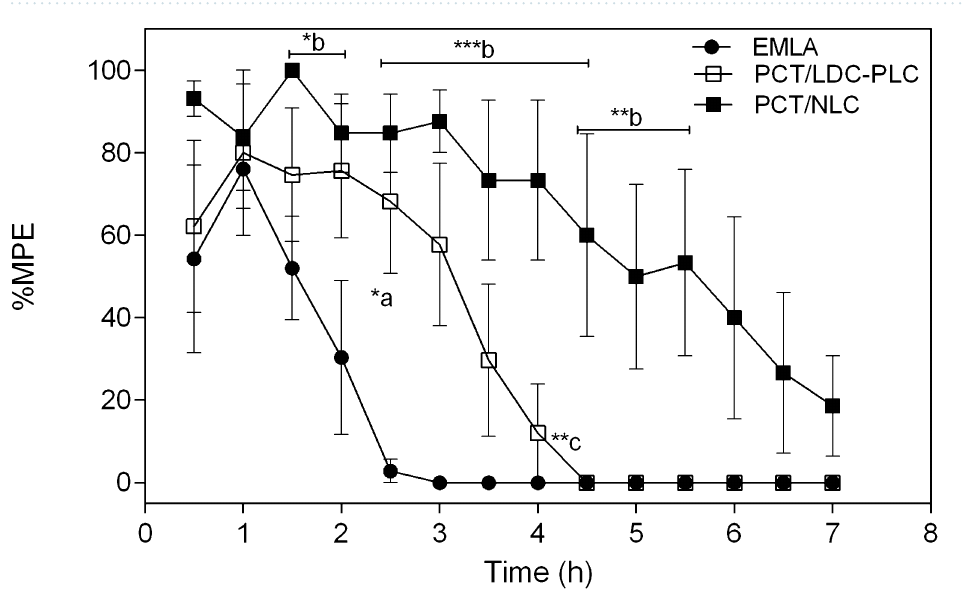
Figure 5. Anesthetic effect (tail-flick) test in mice treated with PCT/LDC-PLC, PCT/NLC and EMLA cream, containing 5% LDC-PLC. Results were expressed as maximum possible effect (%MPE) vs time (h). Data are mean ± SEM (n = 6). Statistical analyses were carried out by one-way ANOVA plus Tukey post hoc: a, PCT/LDC- PLC × EMLA cream; b, PCT/NLC × EMLA; c, PCT/LDC–PLC x PCT/NLC (*p < 0.05, **p < 0.01, ***p < 0.001). PCT pectin, LDC–PLC 5% lidocaine-prilocaine, NLC nanostructured lipid carrier loading 5%